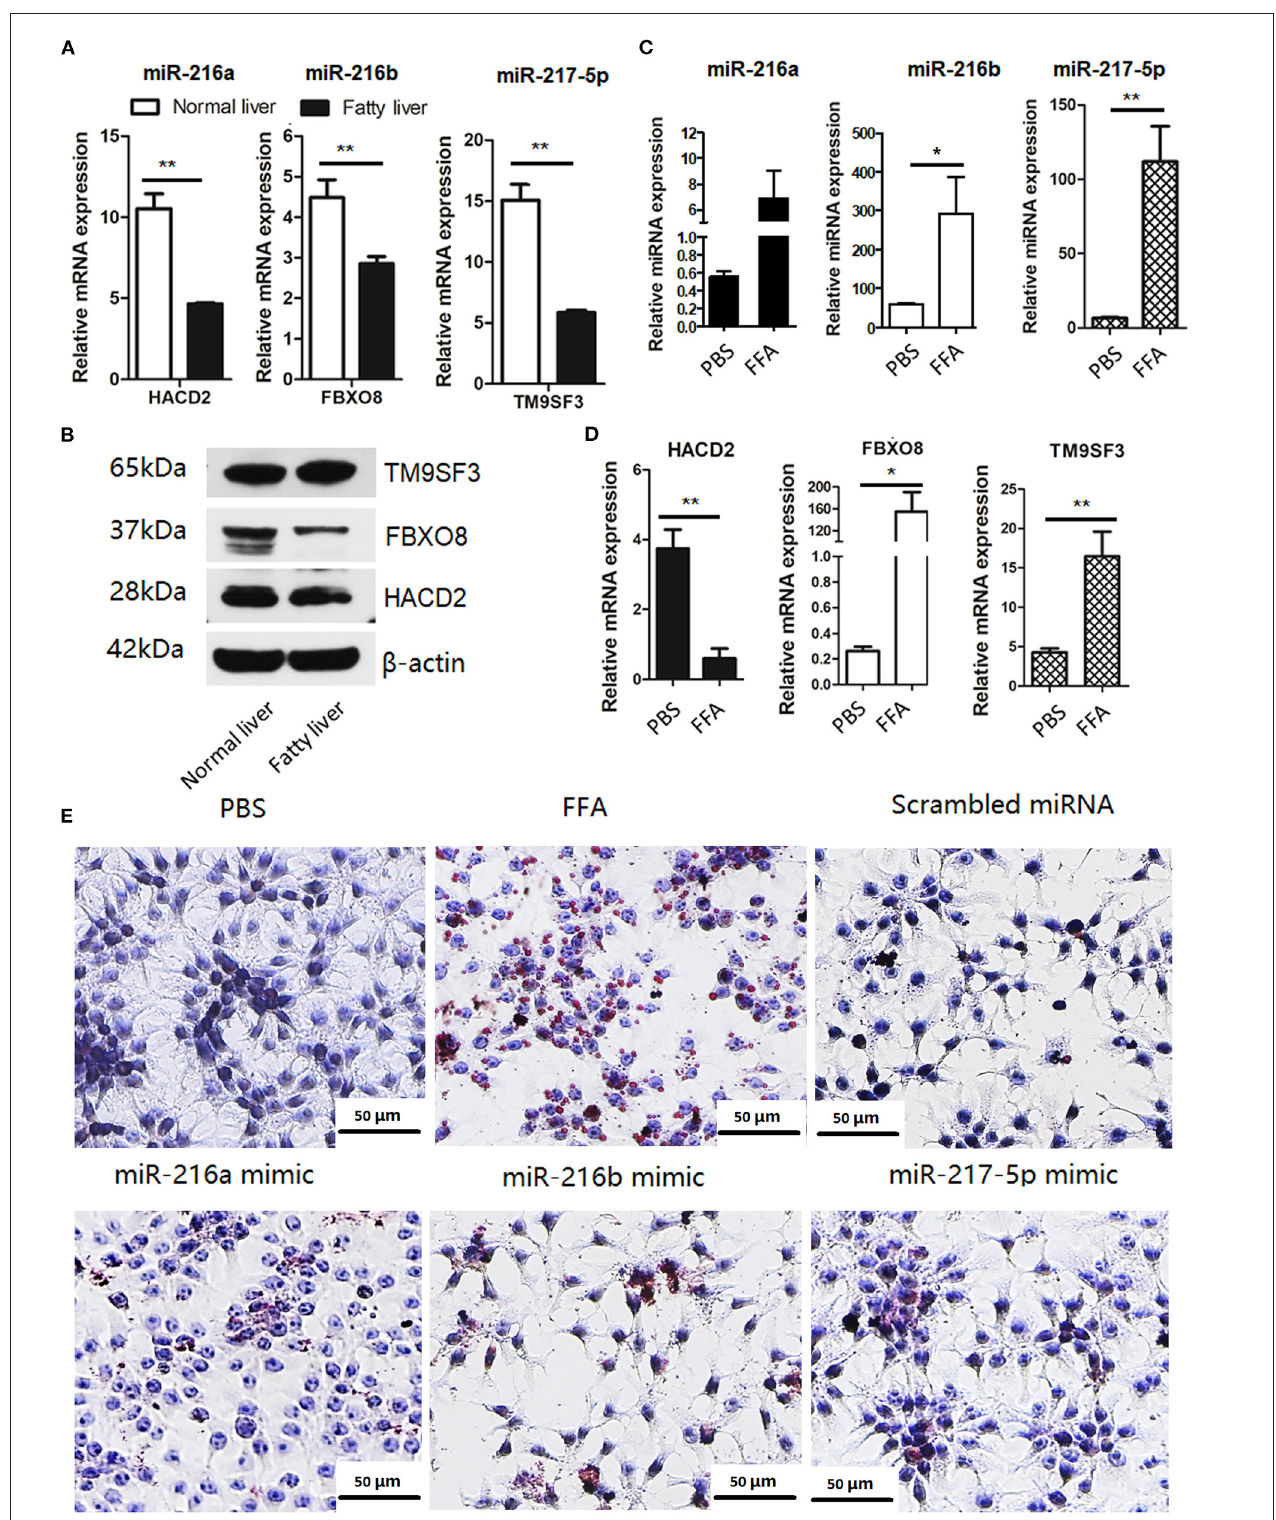
FIGURE 3 | The miR-216/miR-217 cluster was up-regulated in FFA-induced f fatty liver model (A) mRNA levels of potential targets of the in vivo fatty liver model. (B) Protein levels of potential targets of the in vivo fatty liver model. (C) miRNA levels of the miR-216/217 cluster in FFA-induced fatty liver model. (D) mRNA levels of potential targets in FFA-induced fatty liver model. (E) Oil-red O staining (200 × magnification). * P < 0.05 and ** P < 0.01.